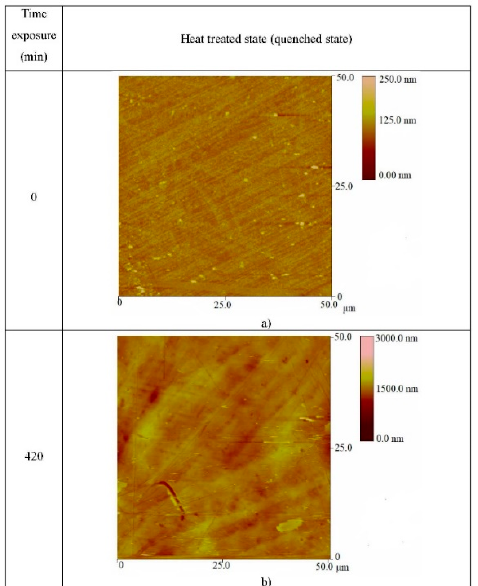
Figure 9. 2D AFM images of the sample after quenching: ( a ) before (50 × 50 × 0.25 μ m 3 ) and ( b ) after (50 × 50 × 3 μ m 3 ) cavitation testing for 420 min.